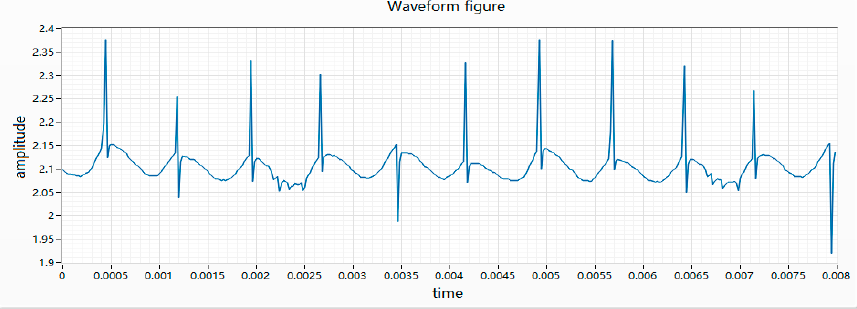
Figure 3. Waveform of a good product.